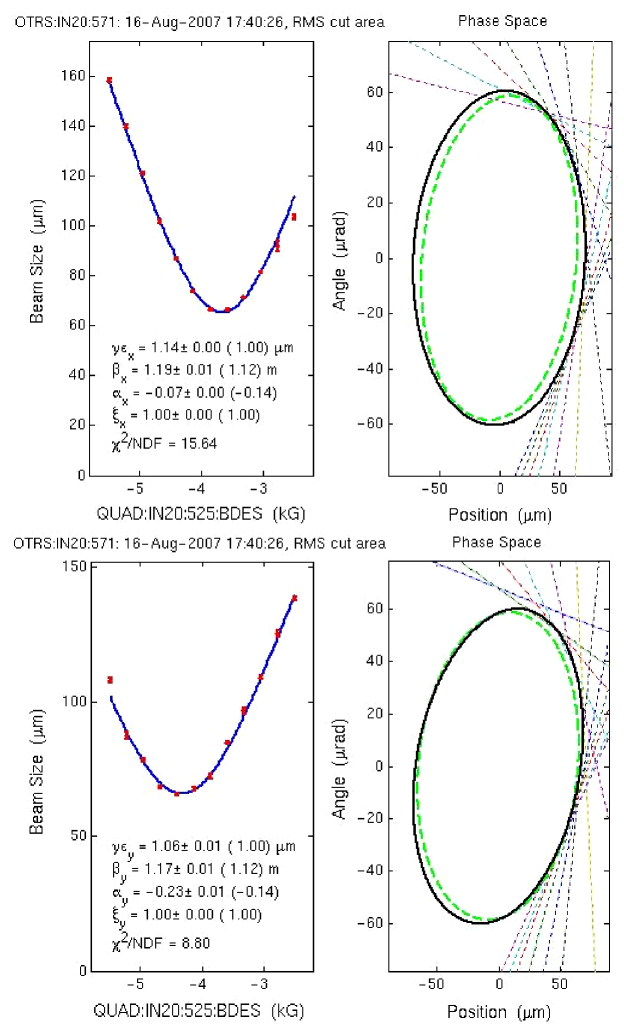
FIG. 27. (Color) Projected normalized x (top) and y (bottom) emittances measured for a 1-nC, 100-A bunch at 135 MeV (cid:3) 1 : 14 (cid:2) m , (cid:1)" (cid:3) 1 : 06 (cid:2) m ). The beta-matching parame- ( (cid:1)" x y ter, (cid:7) (see below) is 1.00 in x and y , showing an ideally x;y matched beam to the design Twiss functions.